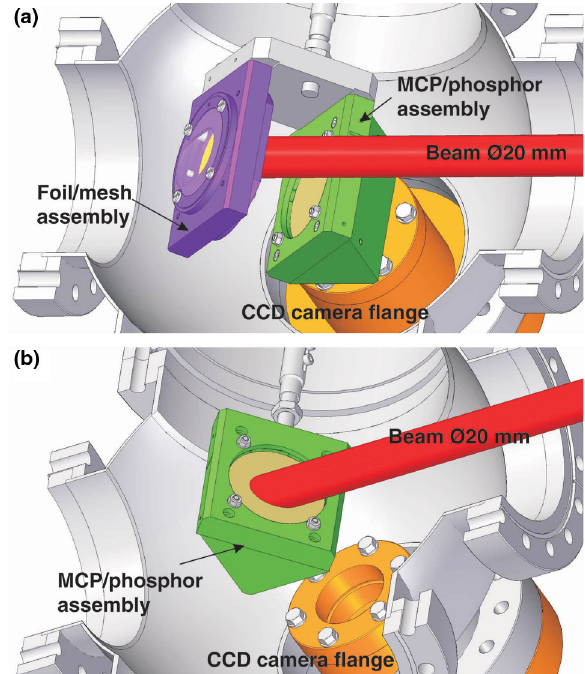
FIG. 6. Two configurations of the secondary emission monitor: (a) foil-based SEM, (b) MCP directly in the